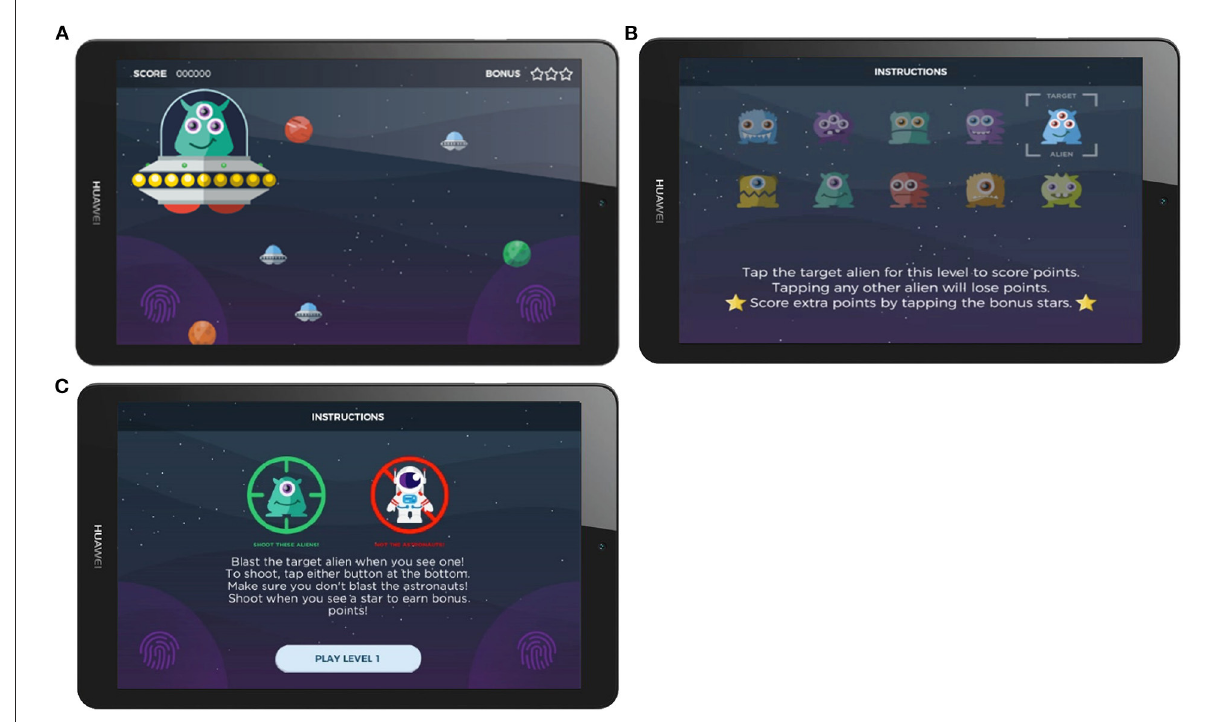
FIGURE1 Screenshots of the gamified Oddball task. (A) Screenshots of the stimulus presentation, (B) Instruction screen in the Older Adult Study, (C) Instruction screen in the Younger Adult